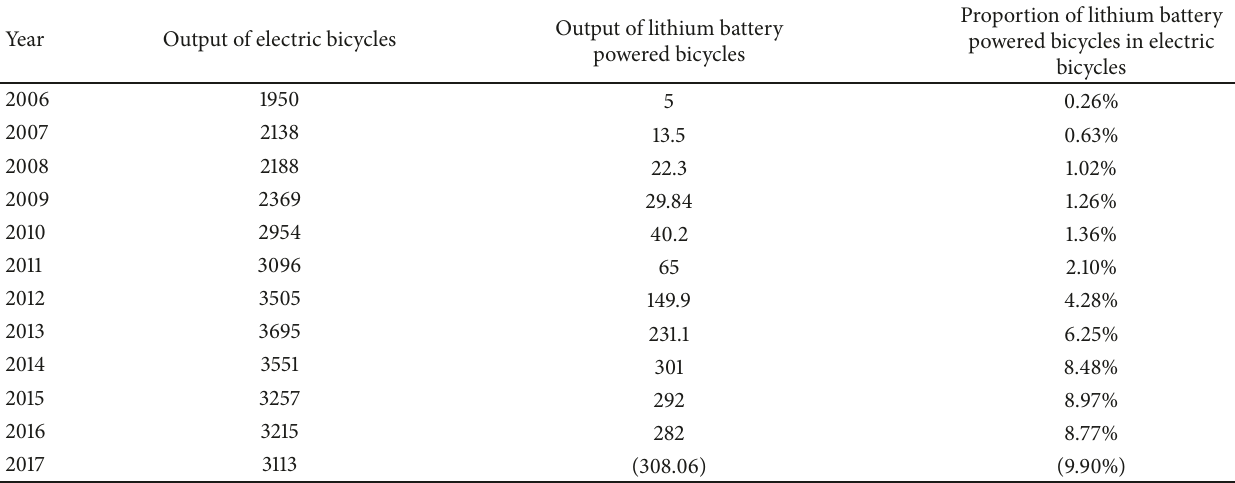
Table 6: Output of lithium battery powered bicycles (unit: 10,000 sets.).